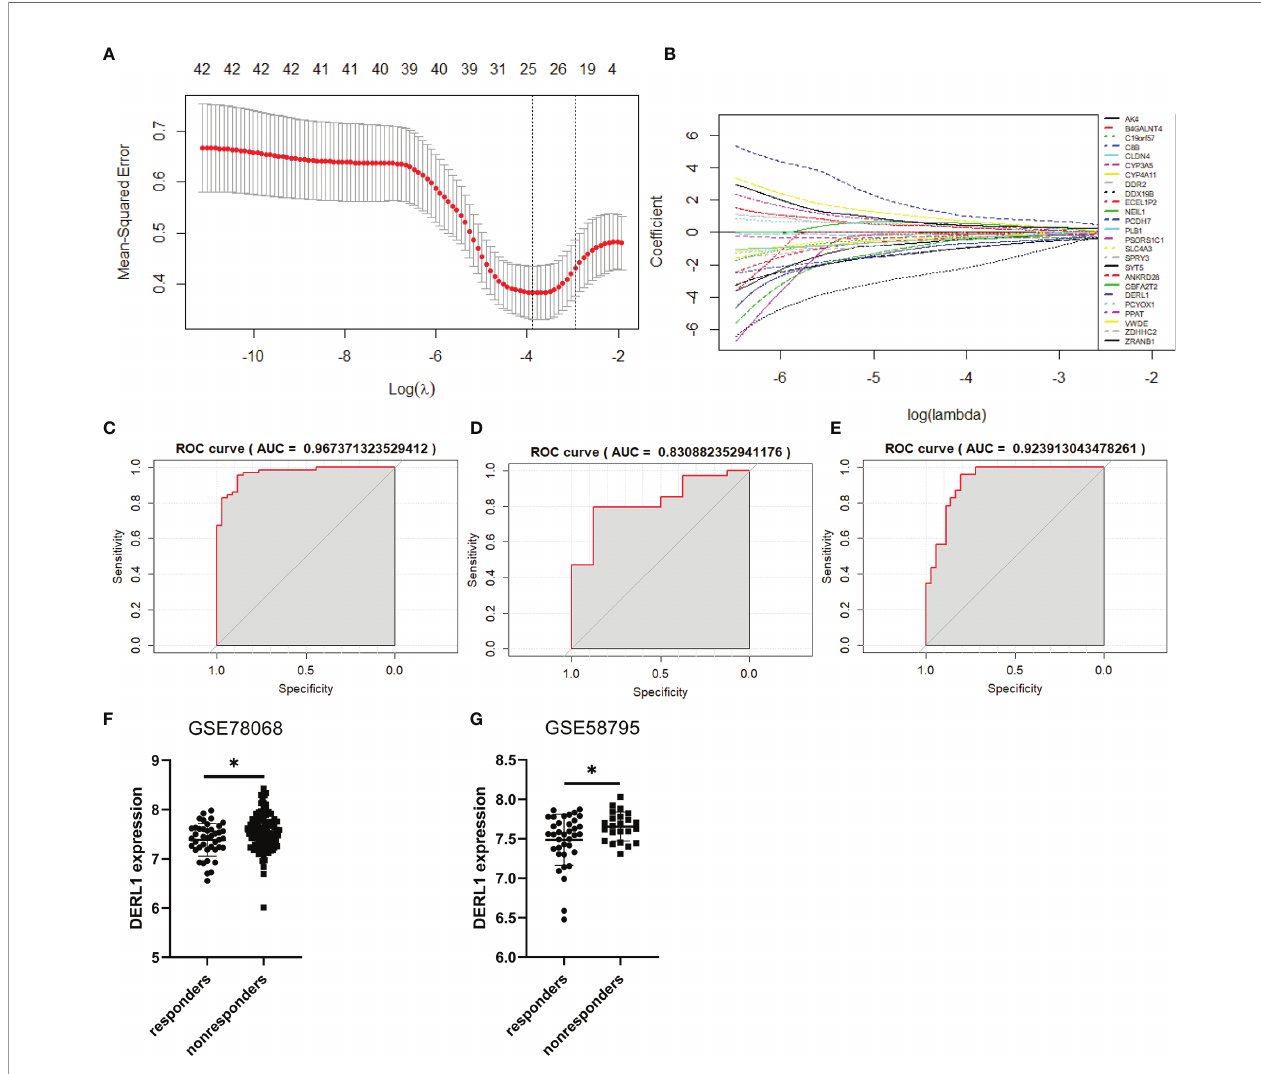
FIGURE 5 | Construction of the prediction model and identi fi cation of the hub genes associated with nonresponse to IFX therapy for RA. (A) Cross-validation for the gene signature selection of optimal lambda value in least absolute shrink and selection operator (LASSO) model. (B) LASSO coef fi cient pro fi les of the 25 prediction genes. (C) The receiver operating characteristic (ROC) curves of the 25-gene signature in training set of GSE78068 dataset. (D) The ROC curves of the 25-gene signature in internal validation set of GSE78068 dataset. (E) The ROC curves of the 25-gene signature in external validation set of GSE58795 dataset. (F, G) Differential expression of DERL1 between responders and nonresponders in GSE78068 and GSE58795 datasets. Student ’ s-t test was used for the data analyses in (F) . Student ’ s- t test with Welch ’ s correction was used for the data analyses in (G) . * P <